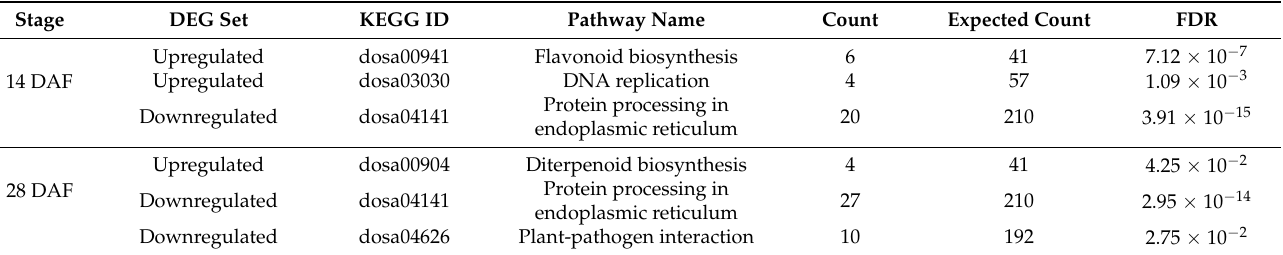
Table 1. Kyoto Encyclopedia of Genes and Genome pathway enrichment analysis of differentially expressed genes between red and white pericarp